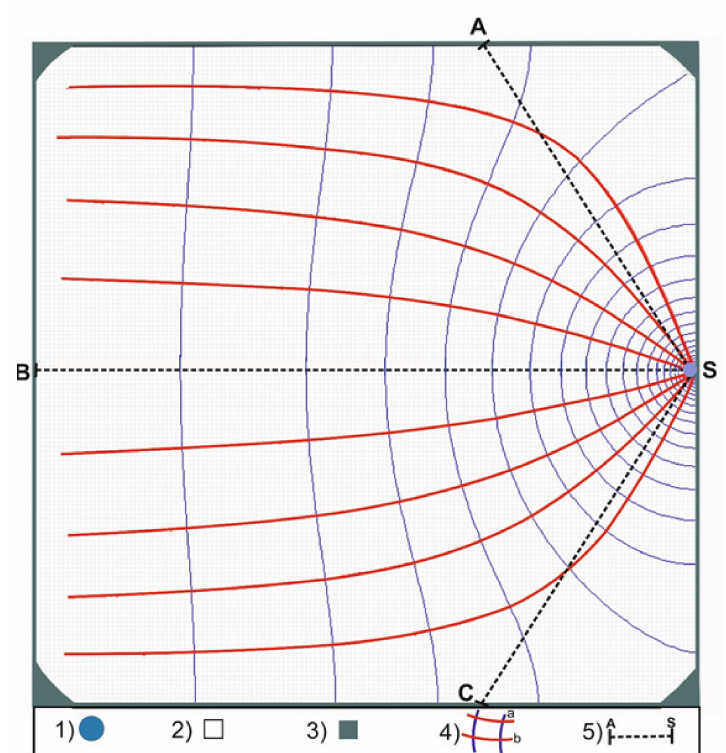
Figure 1. 2D plan-view (horizontal) groundwater model of a homogenous square-shape aquifer, n.22550 cells, with a single drain (spring outlet). (1) spring; (2) active cell (flow zone); (3) inactive cell (no flow zone); (4) flow net with equipotential and flow lines (blue and red color respectively); (5) section